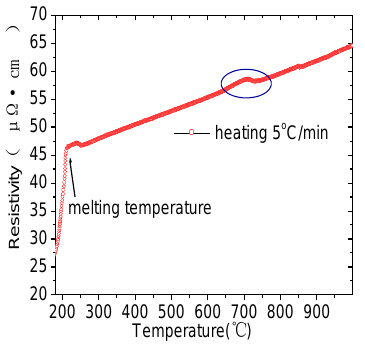
Figure 9. ρ- T curves of In-Sn80.